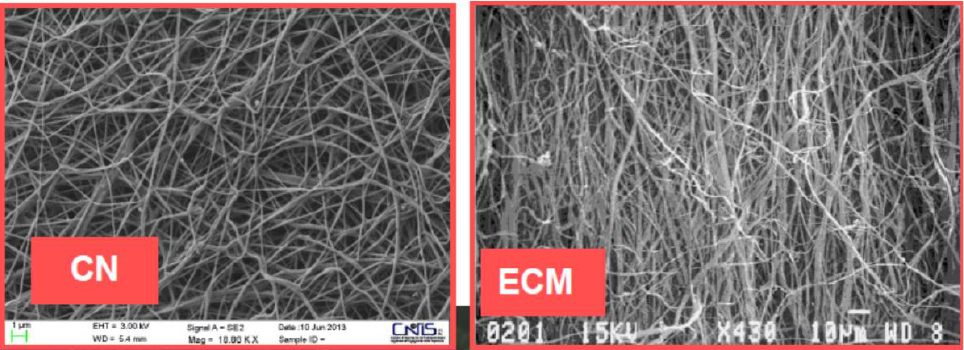
Figure 5. Architecture and porosity of the Chitin nanofibril scaffold ( left ) in comparison with the ECM ones ( right ).